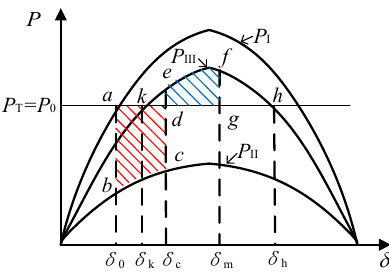
Figure 3. Power characteristic curve of simple system after normal operation, fault and fault removal.